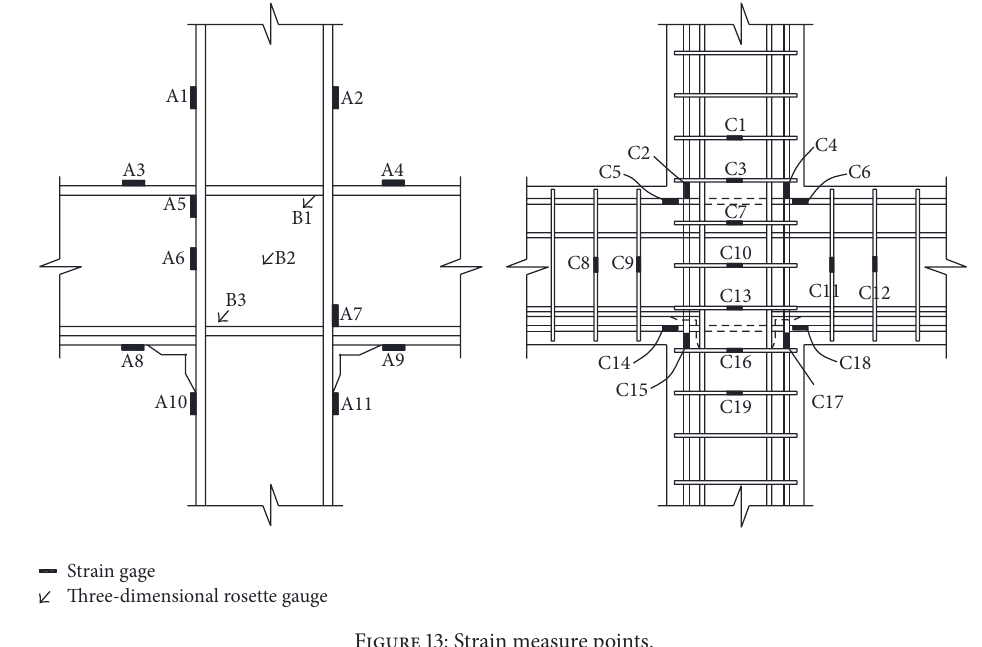
Figure 13: Strain measure points.